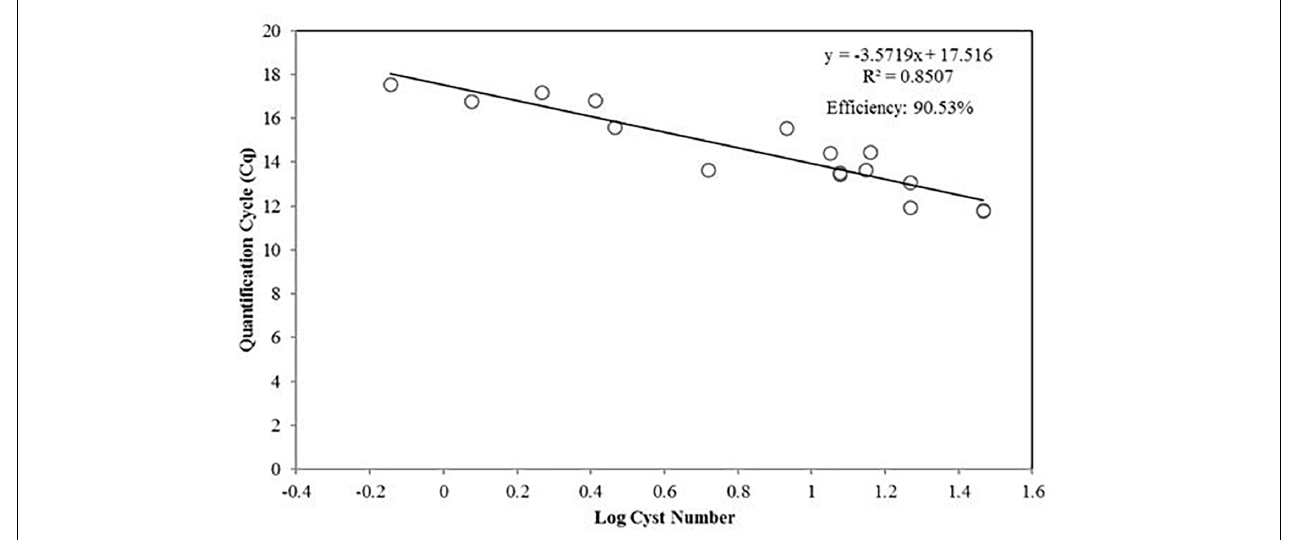
FIGURE 4 | Standard curve presenting the qPCR quantification cycle value ( y -axis) versus the diluted number of A. pacificum cysts in log scale.